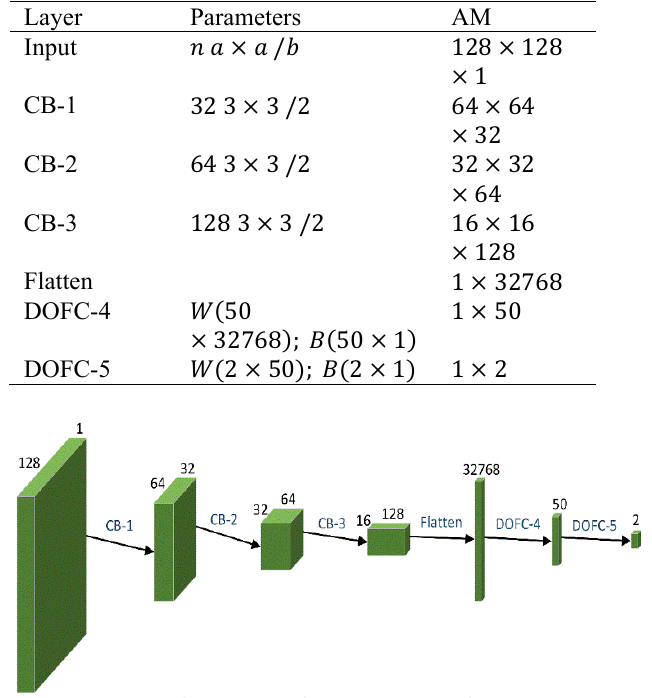
Fig. 11 Structure of proposed 5L-CNN